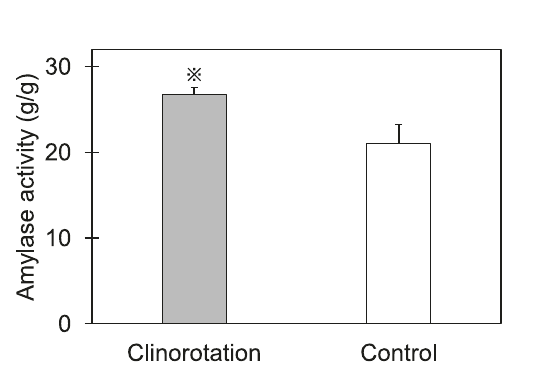
Fig. 2 Amylase activity in cotyledons ( n = 10). Asterisks indicate signi fi cant difference between control and clinorotation.